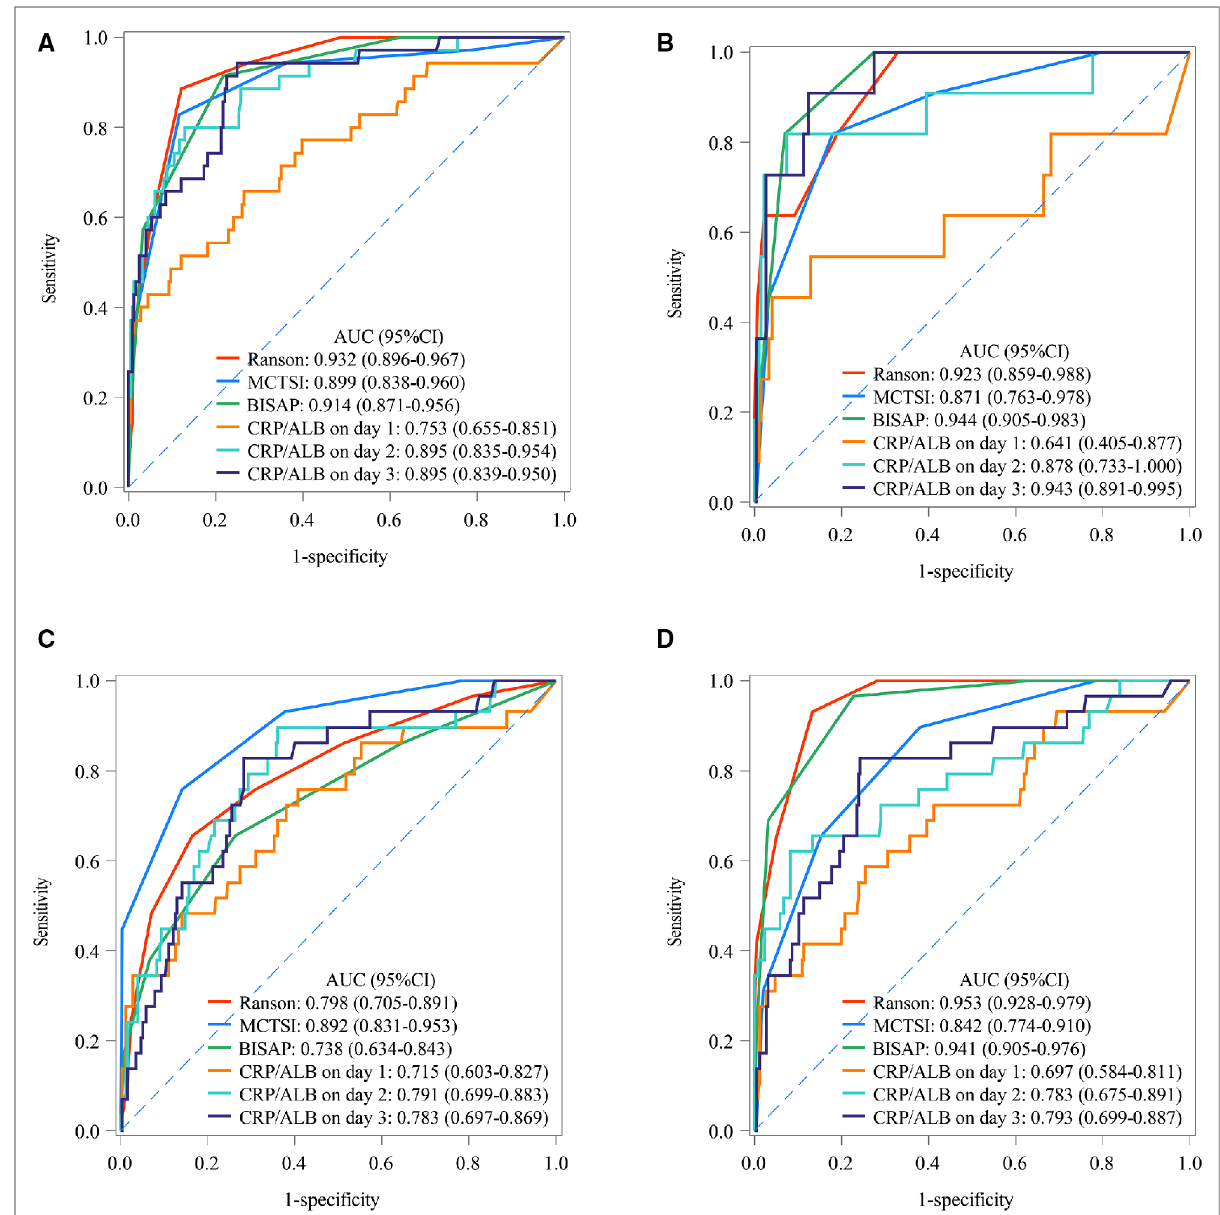
FIGURE 1 The AUC of CRP/ALB ratio, ranson, MCTSI, and BISAP in SAP, death, pancreatic necrosis, and organ failure; ( A ) SAP; ( B ) death; ( C ) pancreatic necrosis; ( D ) organ failure. MCTSI, modi fi ed computed tomography severity index; BISAP, bedside index of severity in acute pancreatitis; AUC, area under the curve; CRP, C-reactive protein; ALB, serum albumin; SAP, severe acute